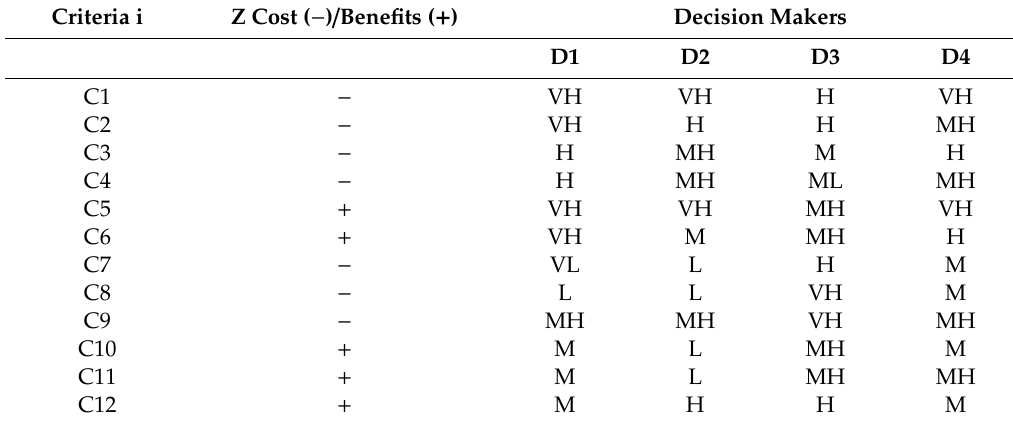
Table A1. Linguistic matrix of importance of subcriteria weights.